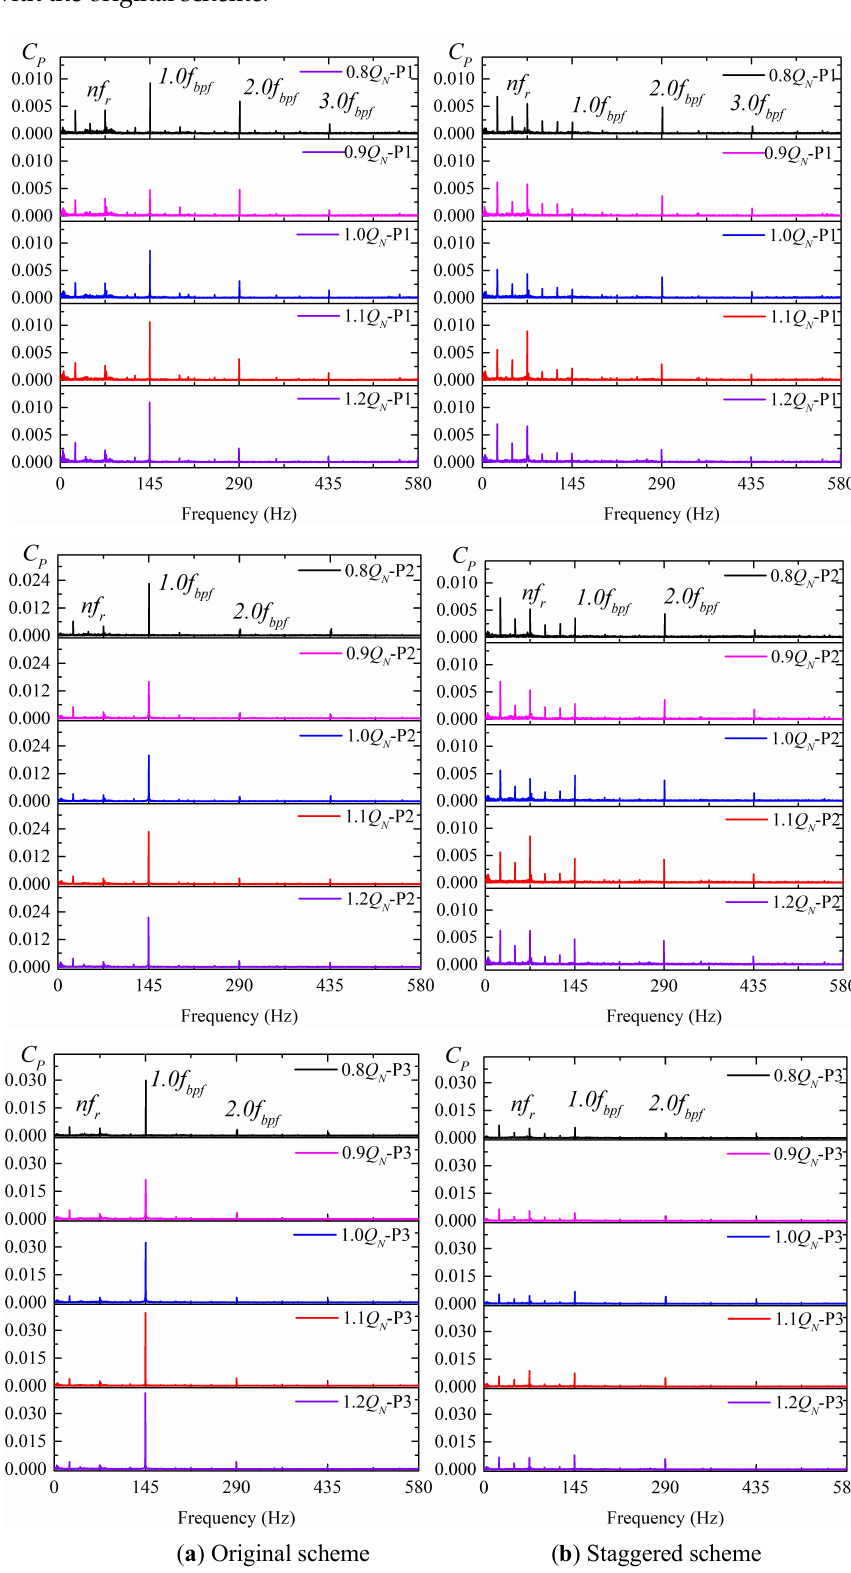
Figure 6. Frequency domain comparison of measured values of different Fig. 6. Frequency domain comparison of measured values of different scheme